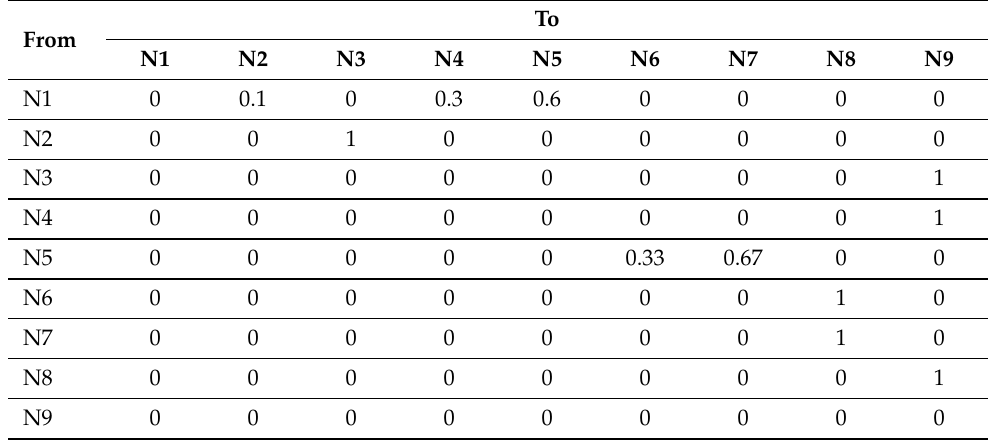
Table 3. Transition matrix (A).